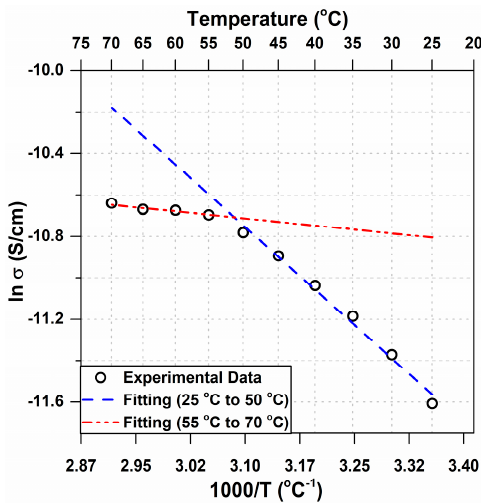
Figure 9 . Arrhenius conductivity fitting for temperatures from 25 °C to 70 °C . Figure 9. Arrhenius conductivity fitting for temperatures from 25 ◦ C to 70 ◦